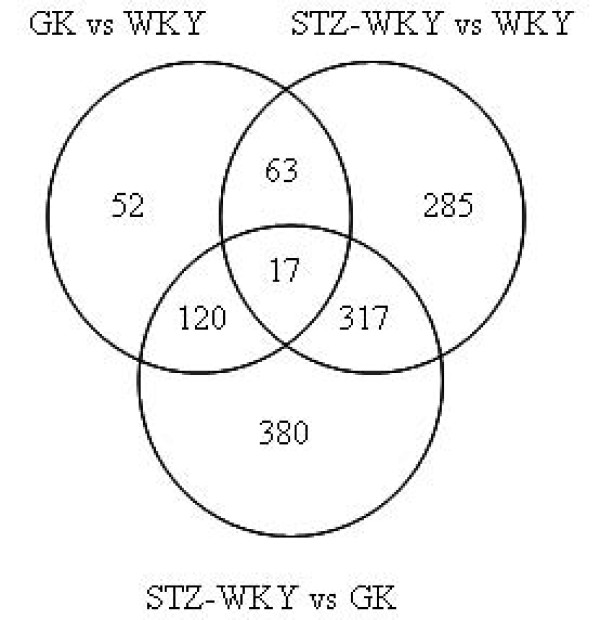
Differentially expressed genes in kidneys of GK and STZ-induced diabetic rat models. Number of Affymetrix probesets corresponding to genes statistically differentially expressed between models (p < 0.05) are shown. The full list of differentially expressed genes between the three models is given in Additional file 4.